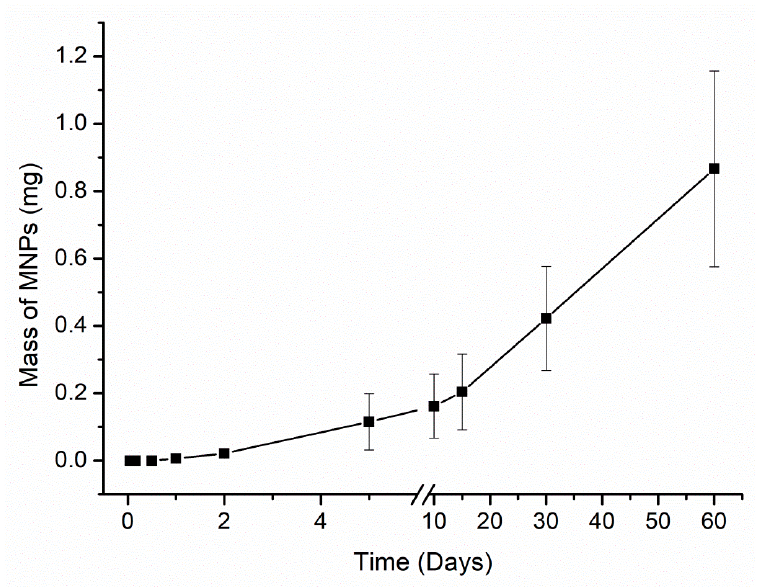
Figure 5. Cumulative elimination profile of Cit-MnFe 2 O 4 MNPs via feces over the period evaluated. Figure 5 indicates that the MNPs elimination precisely starts from two days after